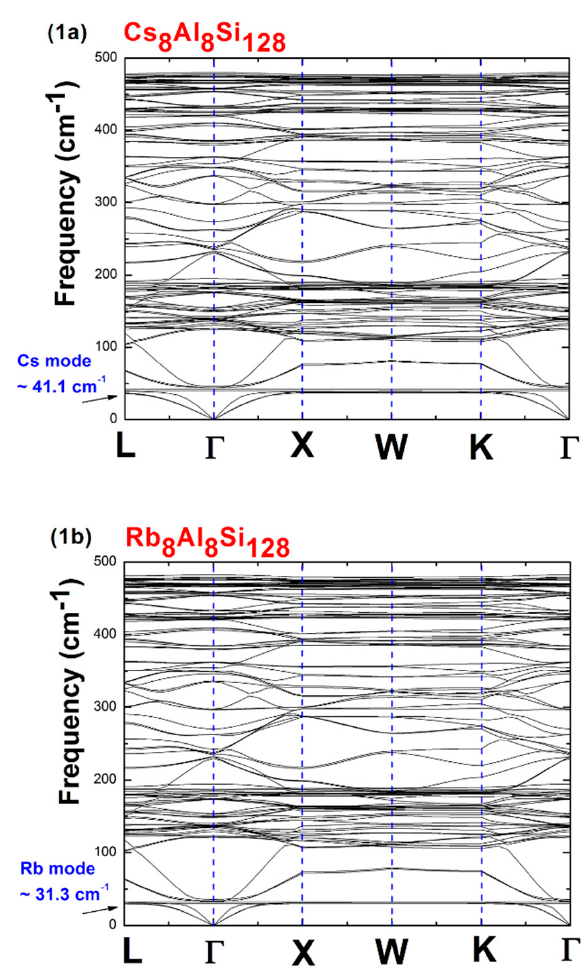
Figure 1. Phonon dispersion relations of: ( a ) Cs 8 Al 8 Si 128 and ( b ) Rb 8 Al 8 Si 128